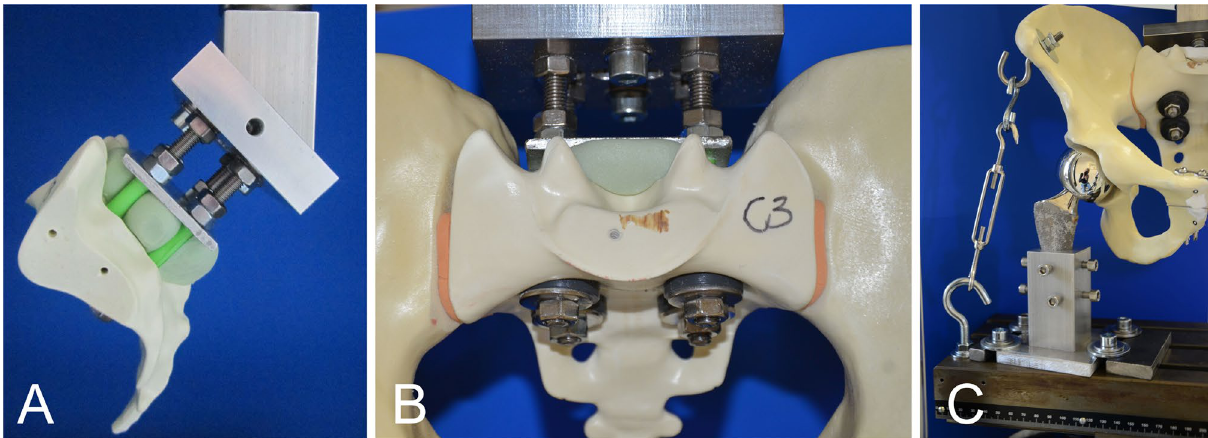
Figure 3. Biomechanical testing. ( A , B ) Fixation of the pelvis to the material testing machine. ( C ) Single-leg- stance model in which load can be applied to one